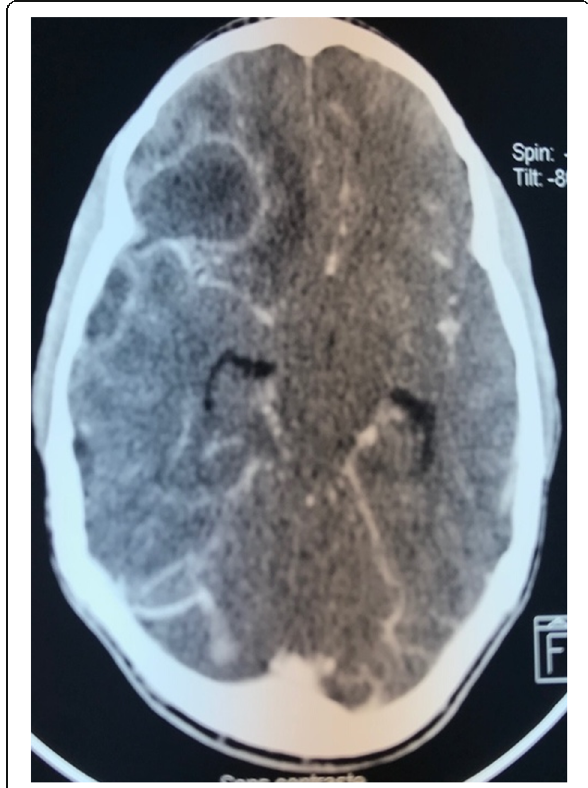
Fig. 4 Frontal abscess associated with